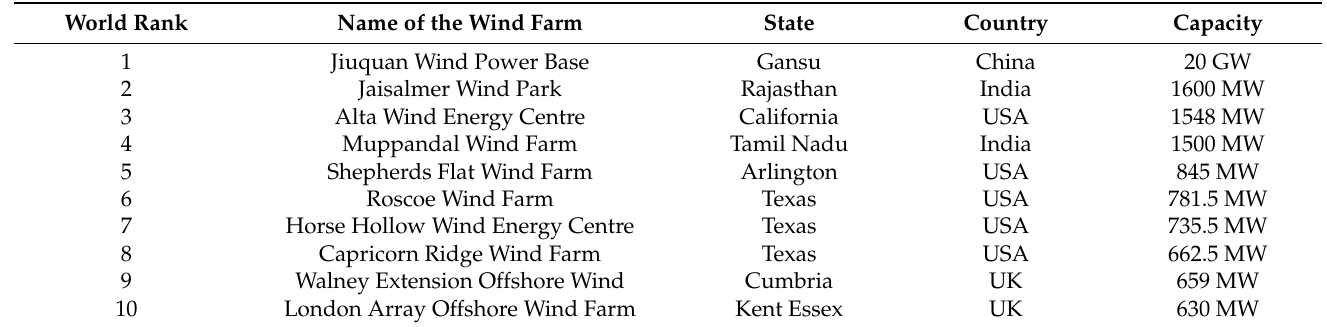
Table 4. Top 10 largest wind farms in world (as on 20 January 2021). Source: Global Energy Observatory [37], Power Technology [38].